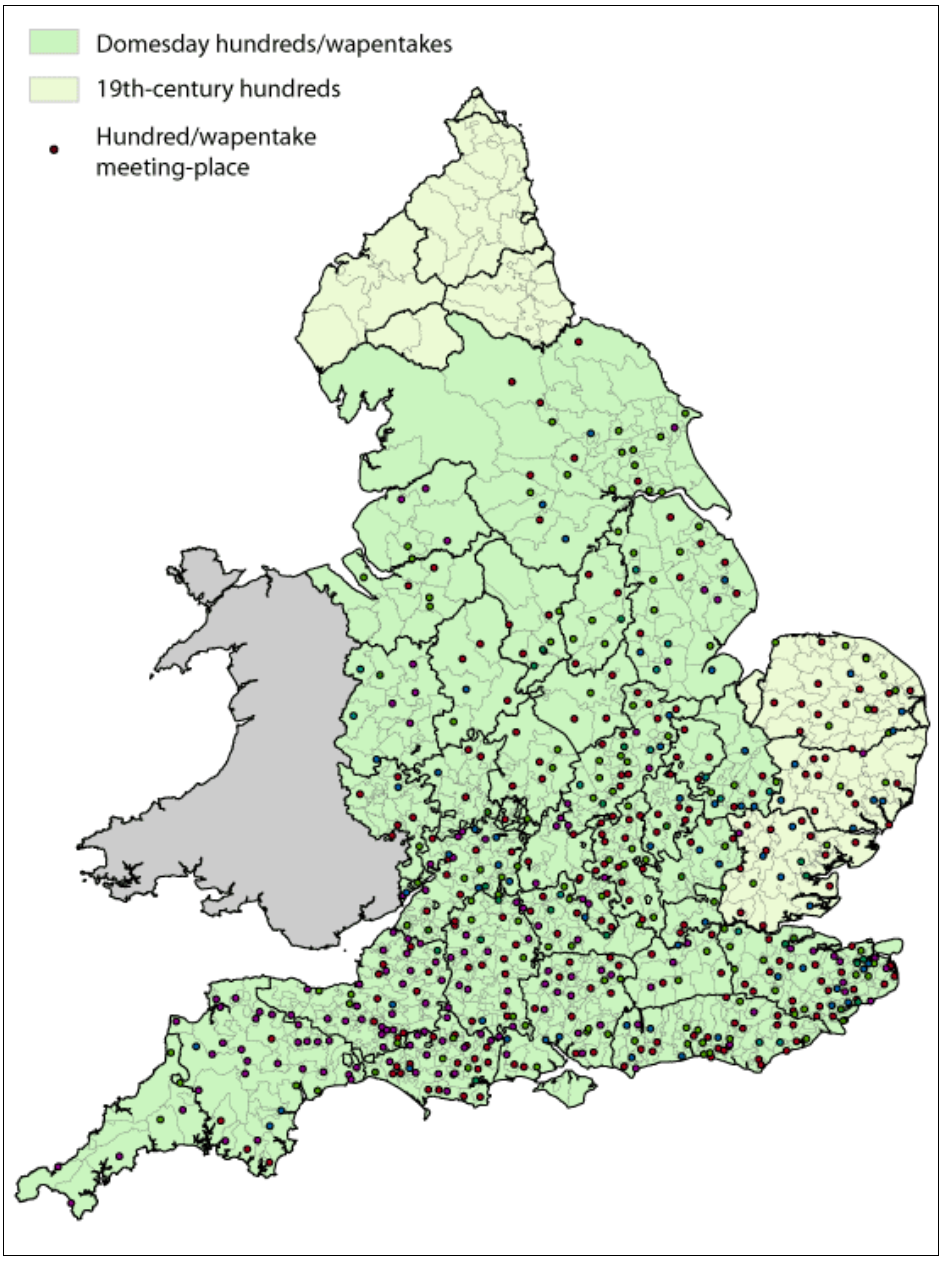
Fig. 1: Map of England showing the arrangement of Domesday hundreds and wapentakes and the location of their meeting-places, as recorded in